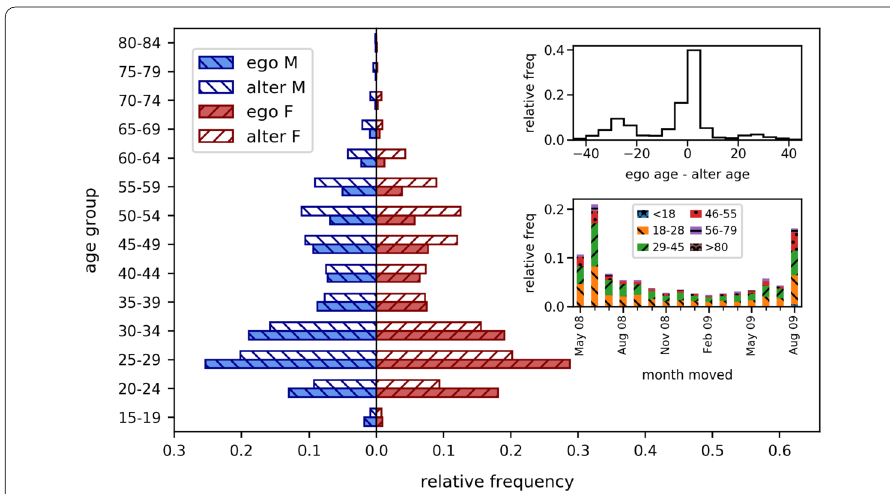
Figure 1 Mobile phone user statistics. The main figure shows the population pyramids for the egos (filled bars) and alters (unfilled bars) showing the relative frequencies for each gender and age group. The upper inset shows the relative frequency histogram of the age difference among the pairs considered, while the lower inset shows the relative frequency histograms of the egos’ moving months, with the composition